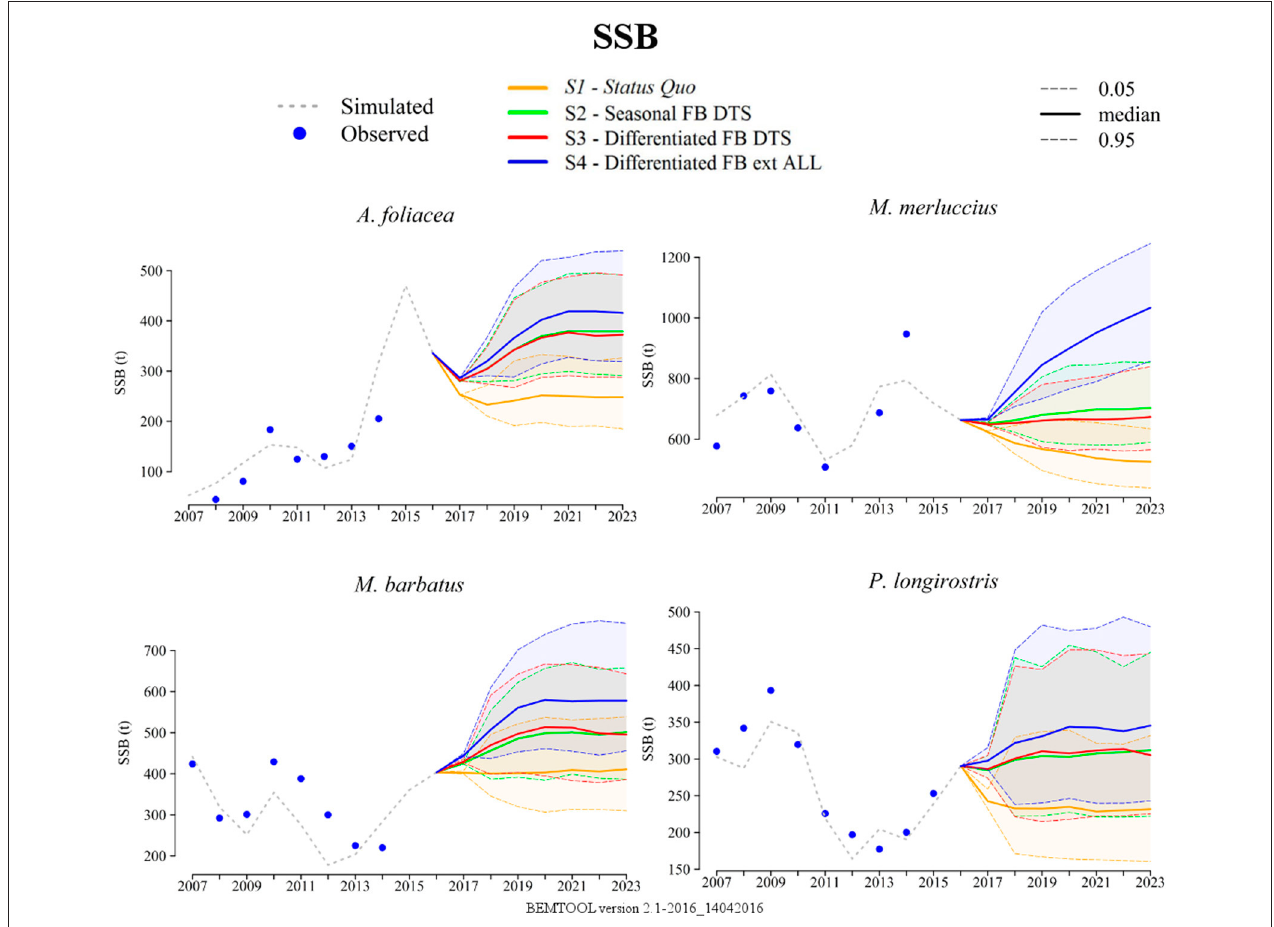
FIGURE 3 | Comparison among the scenarios for the spawning stock biomass (SSB) of the four target stocks in the hindcasting (2007–2016) and forecasting (2017–2023) timelines. Dotted line, Hindcasting from the bioeconomic modeling tool (BEMTOOL); Blue points, estimates from stock assessments.